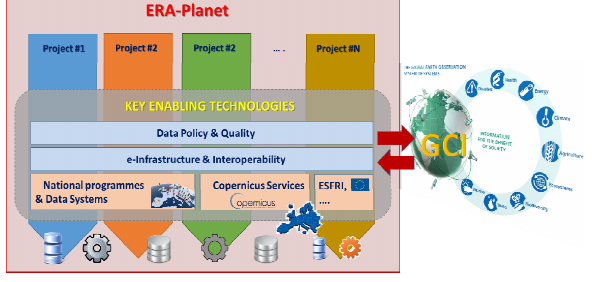
Figure 2. Common Activities in ERA-PLANET Strands by using Key Enabling